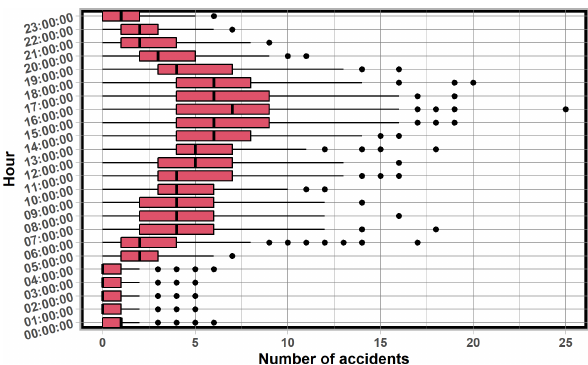
Figure 3: Box-and-whisker plot for road traflc accidents recorded in